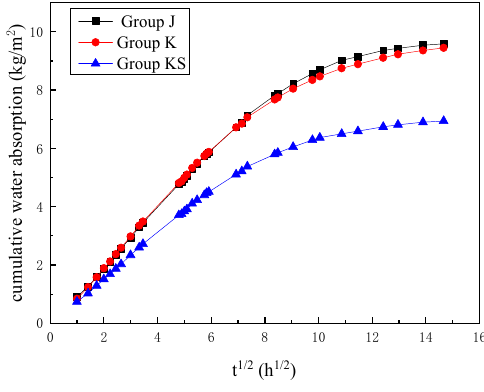
Figure 2. Capillary water absorption test